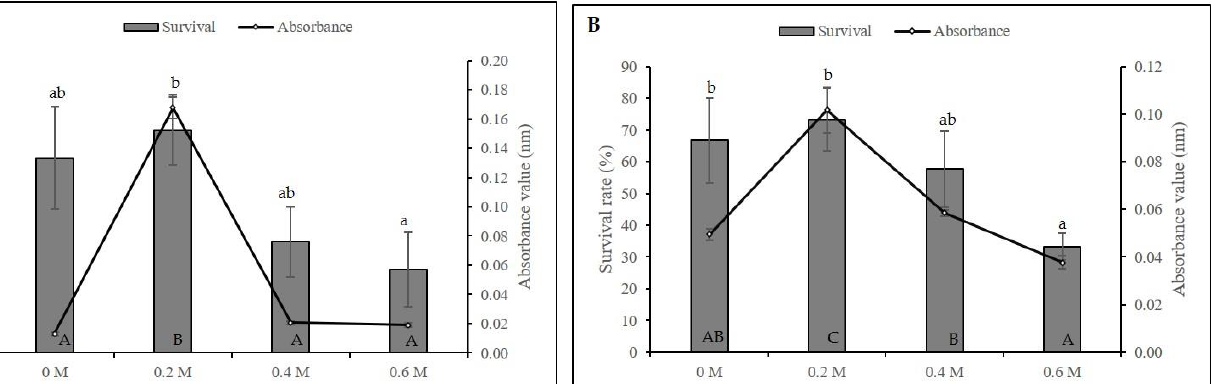
Figure 1. Effect of sucrose concentration during preculture at 24 h on the viability of ( A ) cryopreserved (+LN) and ( B ) non-cryopreserved ( − LN) axillary buds before dehydration and LN immersion. Error bars represent standard errors. Means with different letters (upper case: Absorbance; lower case: Survival) are significantly different based on Duncan Multiple Range Test (DMRT) at p ≤ 0.05.